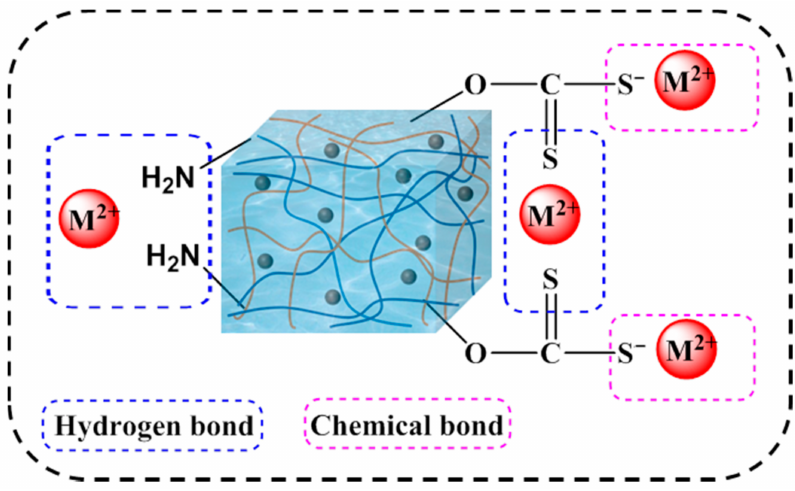
Figure 7. Mechanism of removal of heavy metal ions by magnetic